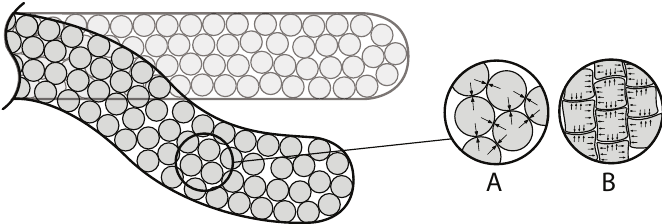
Figure 2. Bulk locking solutions: the arrows represent the interaction forces between the elements. ( A ) Granular jamming: the grains can be locked with each other due to application of an external force; ( B ) turgor pressure: inspired by the plant, the elements can be locked with each other due to internal forces influenced by the surrounding environment.